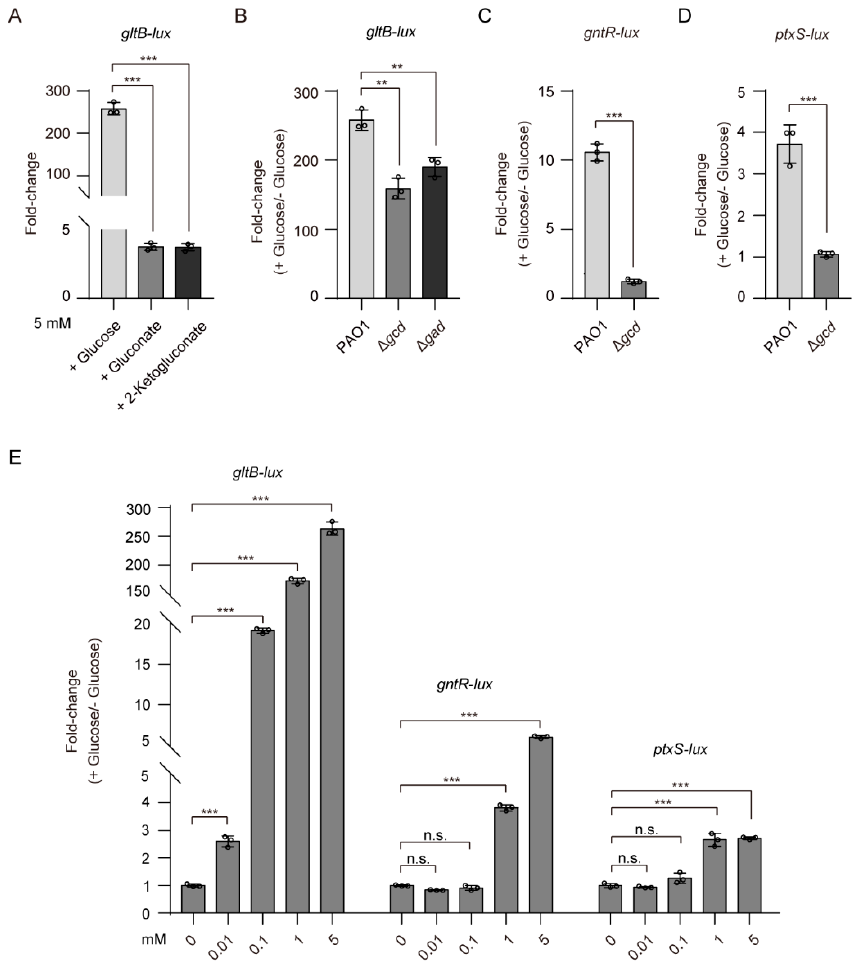
Figure 3. Expression of glucose utilization and metabolism genes. ( A ) Effect of glucose, gluconate, and 2-ketogluconate on the expression of gltB-lux in WT PAO1 strain grown in tubes containing M9 MM at 37 °C with shaking (250 rpm) for 8 h. ( B ) Effect of glucose on the expression of gltB-lux in P. aeruginosa PAO1 and its derivatives grown in tubes containing M9 MM at 37 °C with shaking (250 rpm) for 8 h. ( C , D ) Effect of glucose on the expression of gntR-lux (C) and ptxS-lux (D) in P. aeruginosa strains grown in tubes containing M9 MM at 37 °C with shaking (250 rpm) for 8 h. ( E ) Effect of different concentrations of glucose on the expression of gltB-lux , gntR-lux , and ptxS-lux in PAO1 cultured in tubes containing M9 MM at 37 °C with shaking (250 rpm) for 8 h. In (A to E), data from n = 3 biological replicates reported as mean ± SD. (** p < 0.01, *** p < 0.001, n.s. indicates no significant difference; Student’s two-tailed t -test).